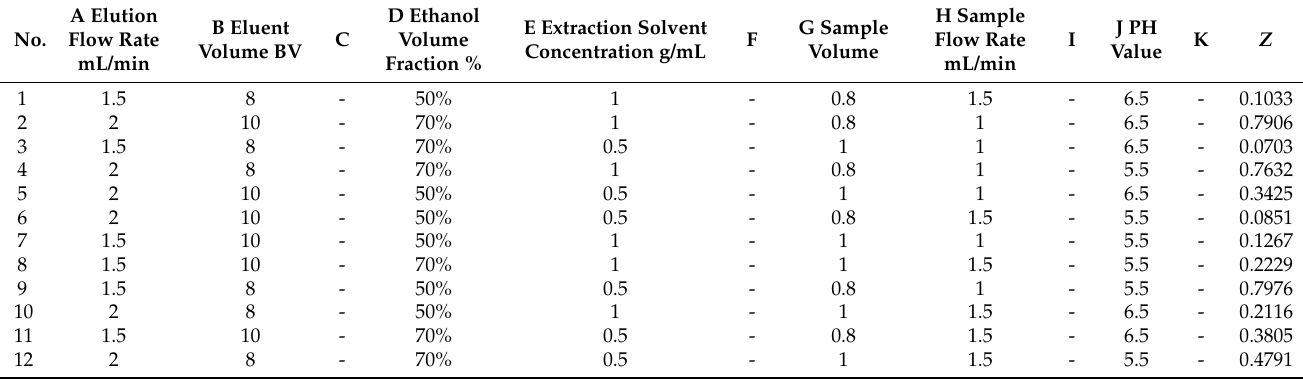
Table 2. Each factor level and Z value in Plackett–Burman design (PBD)